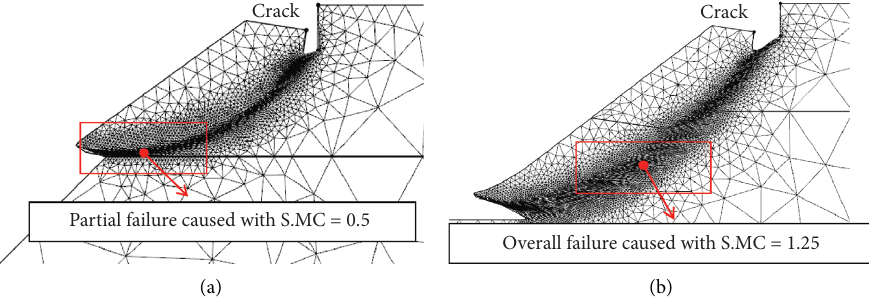
Figure 6: The failure modes of slope at different S. MC values. (a) S. MC � 0.5. (b) S. MC �